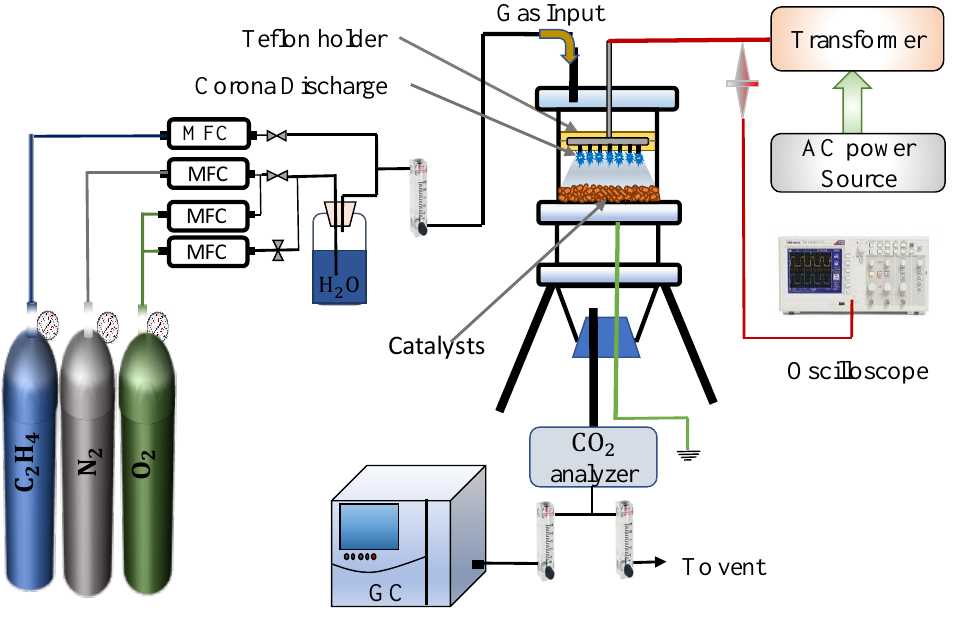
Figure 9. Schematic diagram of the Corona discharge-coupled catalytic reactor (CDCCR) system for removal of C 2 H 4.